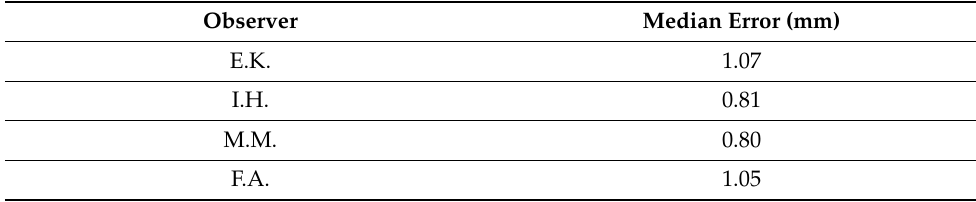
Figure 6. Mean point-wise errors for only E.K. and F.A. Table 1. Median errors for each observer across all